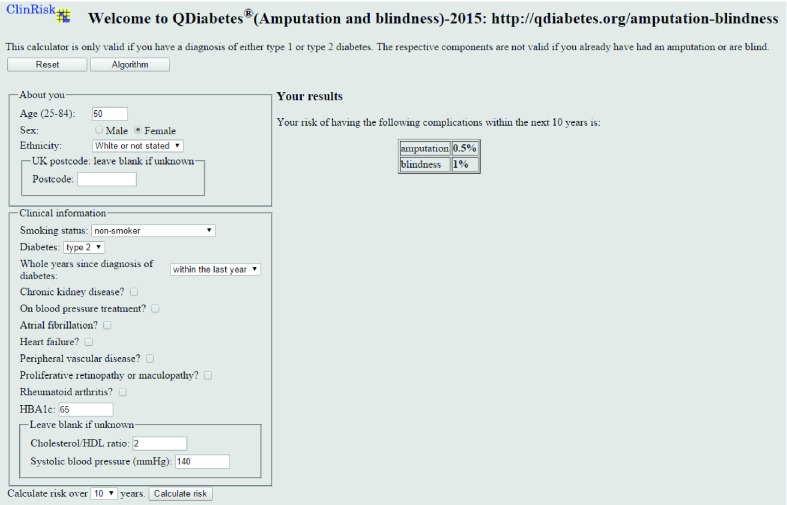
Fig 6 Web calculator applied to example female patient